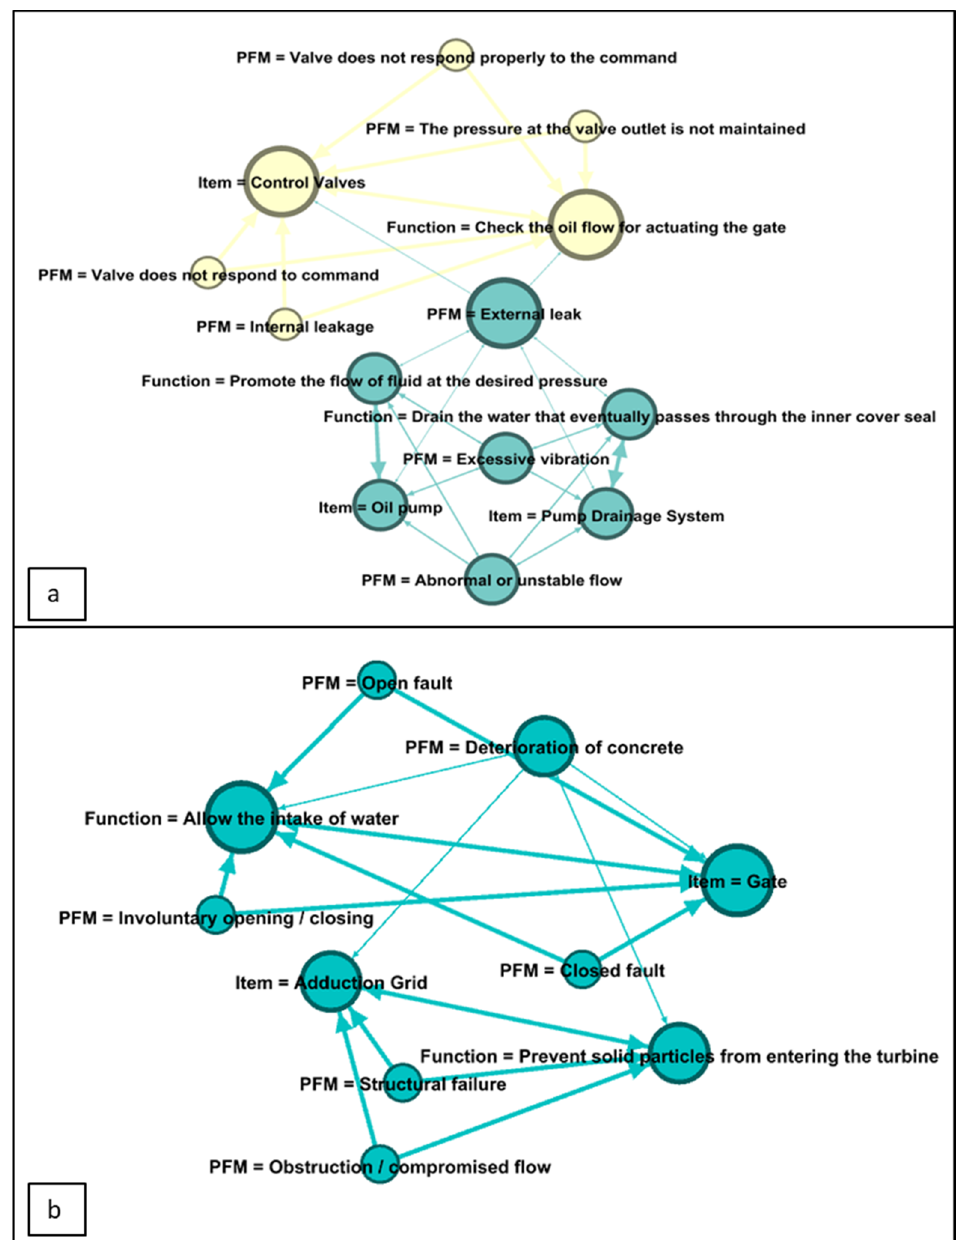
Figure 2. Relationships among potential failure modes, items, and functions. ( a ) refers to Figure 1i; ( b ) refers to Figure 1d.